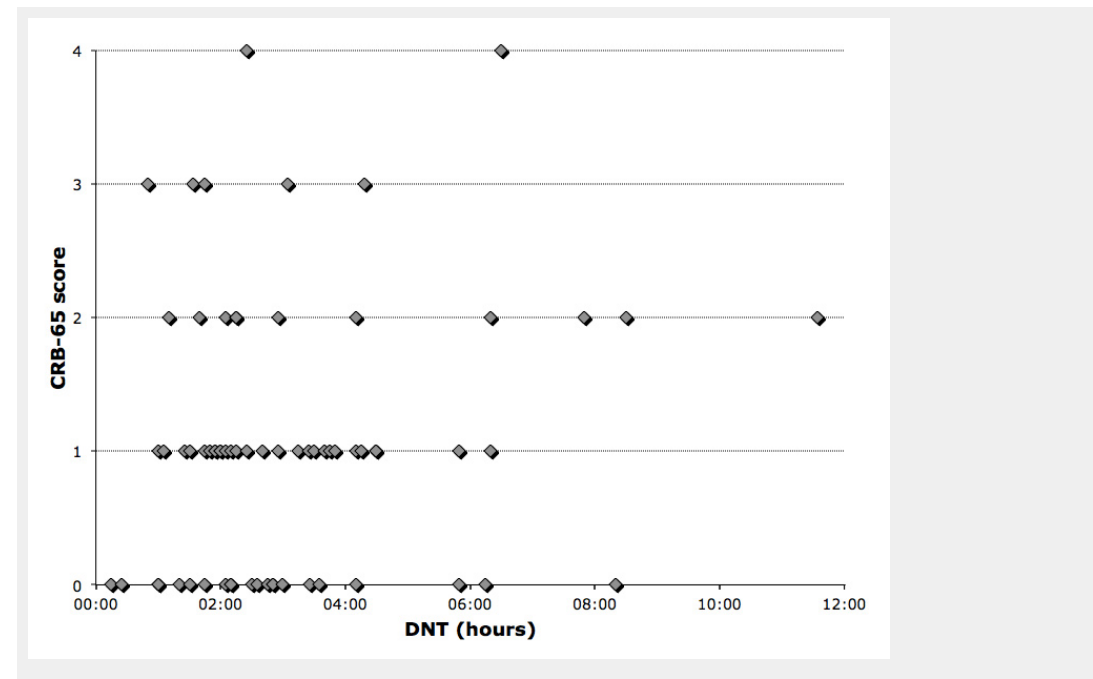
Figure 3 Relation between door-to-needle-time (DNT) und CRB-65 in community acquired pneumonia patients.